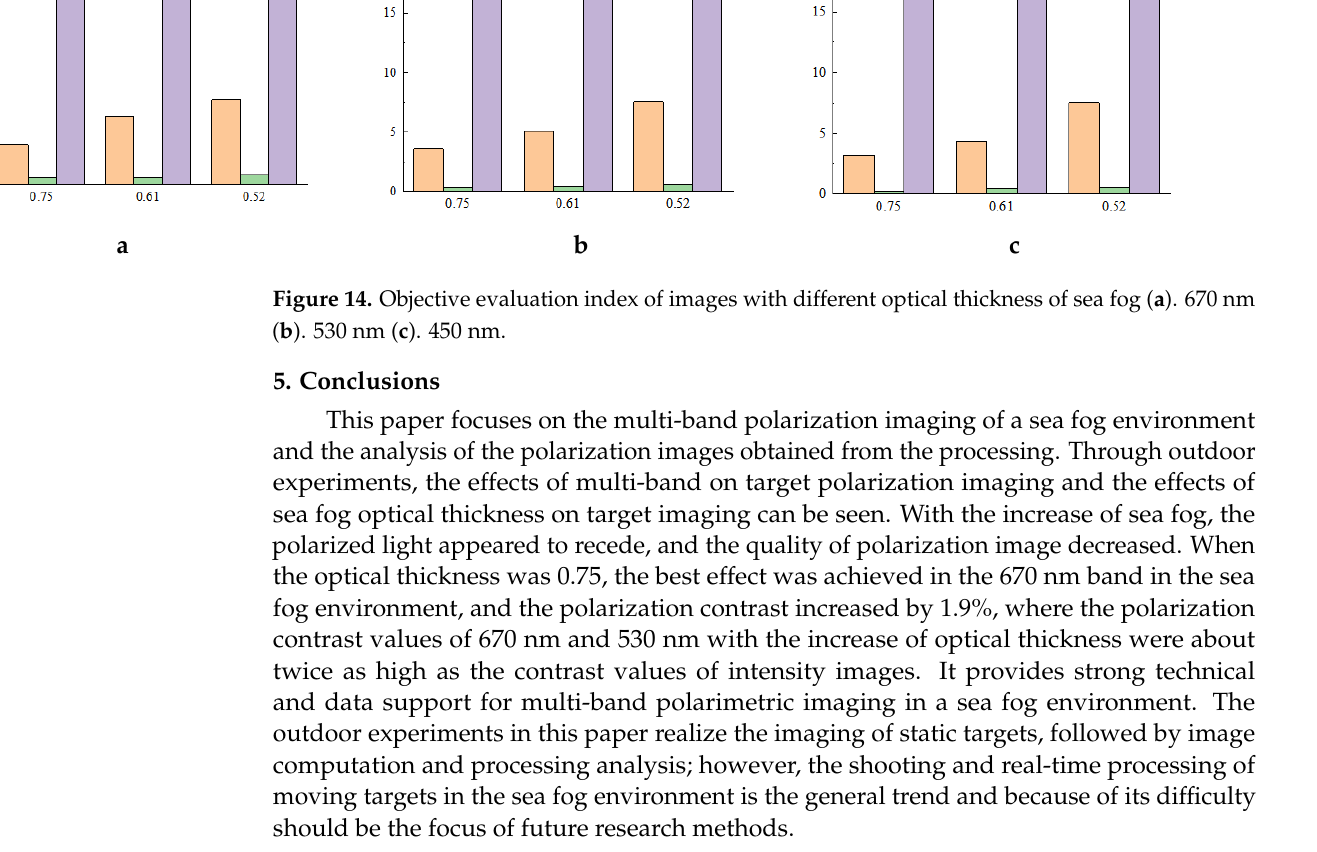
( b ) Figure 13. Contrast of multi-band images with different sea fog visibility ( a ) Intensity image; ( b ) Polarization image. The analysis of the experimental histogram reveals that as the value of sea spray op- tical thickness increases, the polarization contrast decreases and the image blurs, but the polarization contrast in the 670 nm band is greater and more favorable for observation at varying sea spray optical thicknesses. At an optical thickness of 0.75 in this band, the po- larization contrast of the polarization image increases from 1.96% to 3.86%, a 1.9% increase compared to the polarization contrast of the intensity image, whereas the bands of 530 nm and 450 nm increase by 1.08% and 0.28%, respectively, indicating that when the optical thickness value is 0.75, the polarization contrast value of the polarization image at 670 nm increases more. The polarization contrast values of the polarization pictures at 670 nm and 530 nm grow almost twice as much as the polarization contrast values of the intensity images as the optical thickness increases. When the optical thickness increased from 0.52 to 0.75, the polarization contrast of the polarization images decreased by approximately 4.55 percent, 4.68 percent, and 5.29 percent at 670 nm, 530 nm, and 450 nm, respectively, due to the increase in the radius of the sea salt aerosol particles, which decreased the po- larization of the images. Figure 14 shows the objective assessment indices of the photographs under varying sea fog optical thicknesses. According to the data in the figure, it is intuitively apparent that the greater the optical thickness, the lower the objective indexes, the poorer the visual